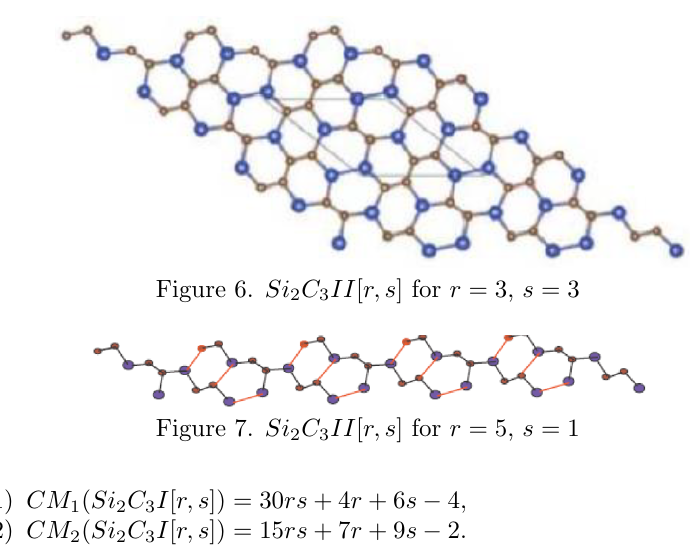
Figure 5. Unit Cell of Si 2 C 3 II [ r, s ]